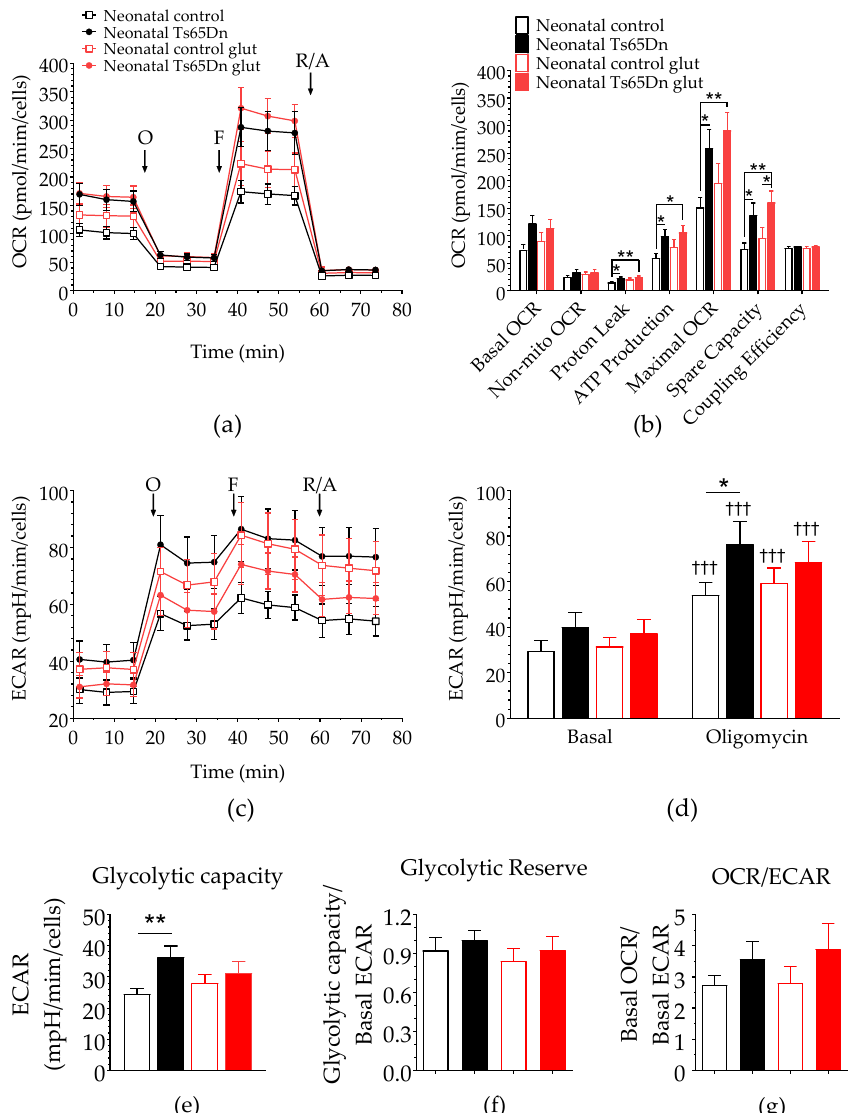
Figure 4. Effect of glutamate stimulation on astrocytic bioenergy in neonatal Ts65Dn and control mice. ( a ) Real-time changes in oxygen consumption rate (OCR) after treatment with oligomycin (O), FCCP (F), and rotenone/antimycin A (R/A). ( b ) Individual parameters derived from OCR profiles. Spare respiratory capacity was significantly higher in neonatal Ts65Dn astrocytes compared with neonatal control astrocytes after addition of glutamate. ( c ) Real-time changes in extracellular acidification rate (ECAR) after treatment with O, F, and R/A. ( d ) Basal and oligomycin ECAR (ECAR after oligomycin treatment) derived from ECAR profiles. ( e ) Glycolytic capacity (calculated by subtracting the basal ECAR value from the ECAR value after oligomycin treatment), which did not differ between the groups after glutamate injection. ( f ) Glycolytic reserve (calculated by dividing the glycolytic capacity by the basal ECAR value and ( g ) OCR/ECAR ratio. Data are expressed as the mean ± SEM ( n = 9–13 independent experiments with samples in triplicate); * p < 0.05, ** p < 0.01, and ††† p < 0.001 indicate differences between before and after treatment for a given genotype.